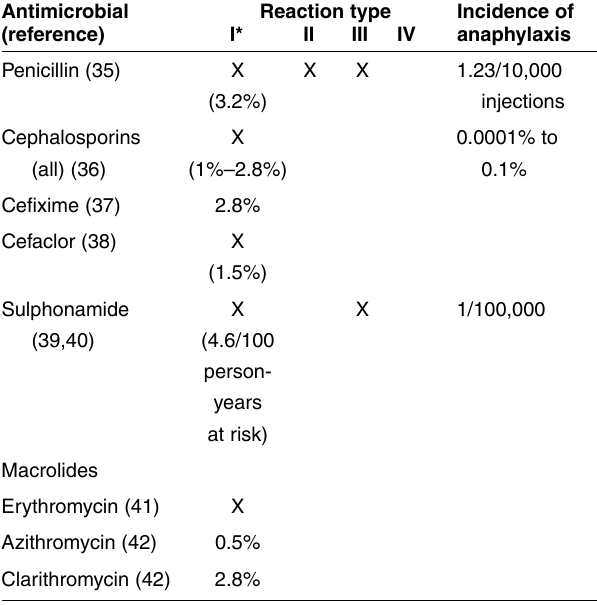
TABLE 2 Allergic reactions to some commonly used antibiotics in children